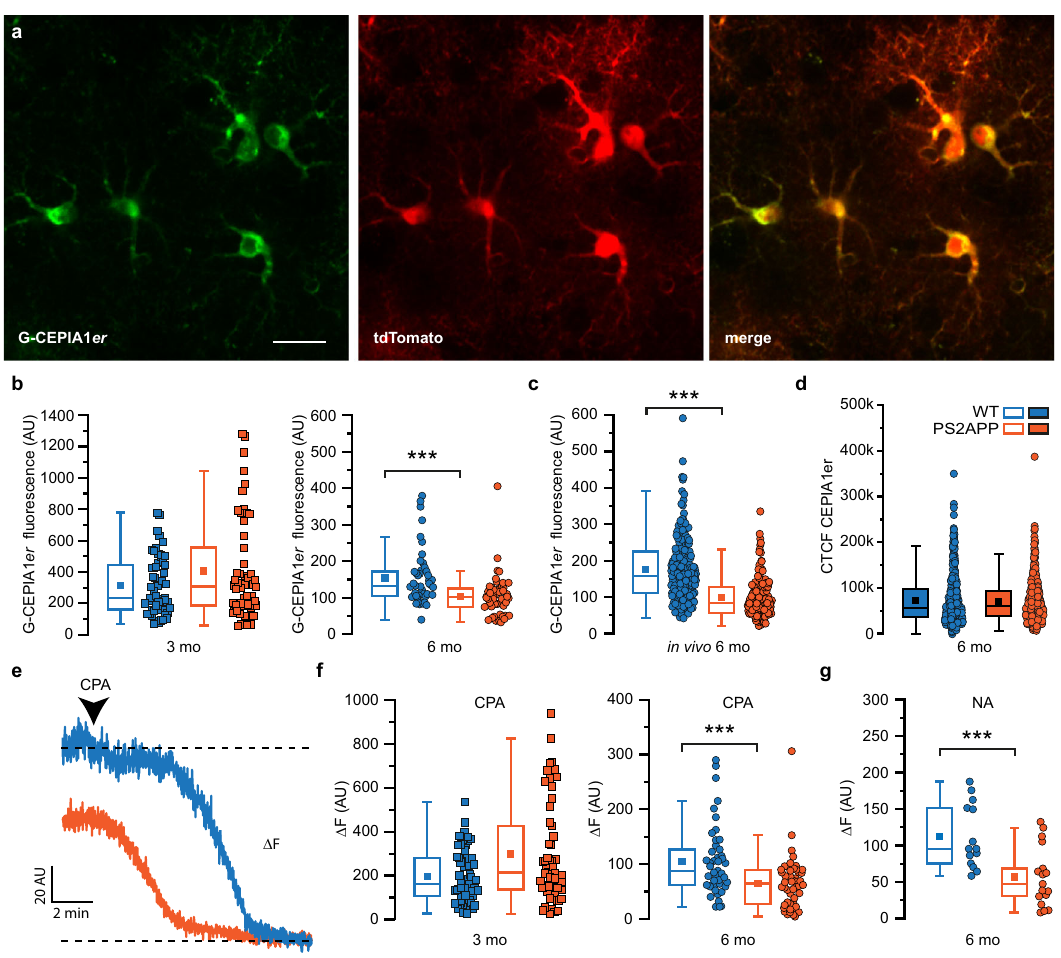
Fig. 5 | Somatic [Ca 2+ ] ER levels in SSCx astrocytes from WT and PS2APP mice. a Representative 2P images of astrocytes expressing G-CEPIA1 er and tdTomato from 6mo WT mice (averageprojections of 50frames). Scale bar20 µ m. b Boxand scatter plots of somatic G-CEPIA1 er fl uorescence values in SSCx slices, p =1.44E − 4. 3mo: n =57 astrocytes from 6 WT and 53 astrocytes from 4 PS2APP mice; 6mo: n=45astrocytesfrom8WTmiceand 50astrocytesfrom7PS2APPmice.Boxplots show mean, median, 25th and 75th percentile, outliers. c Same as b , but from 6mo in vivo anesthetized animals, p =2.64E-21. n =200 astrocytes from 2 WT and 140 astrocytesfrom2PS2APPmice. d BoxandscatterplotsofCTCFvaluesinastrocyte somata immunolabeled with a-GFP to reveal G-CEPIA1 er signal. n =466 astrocytes